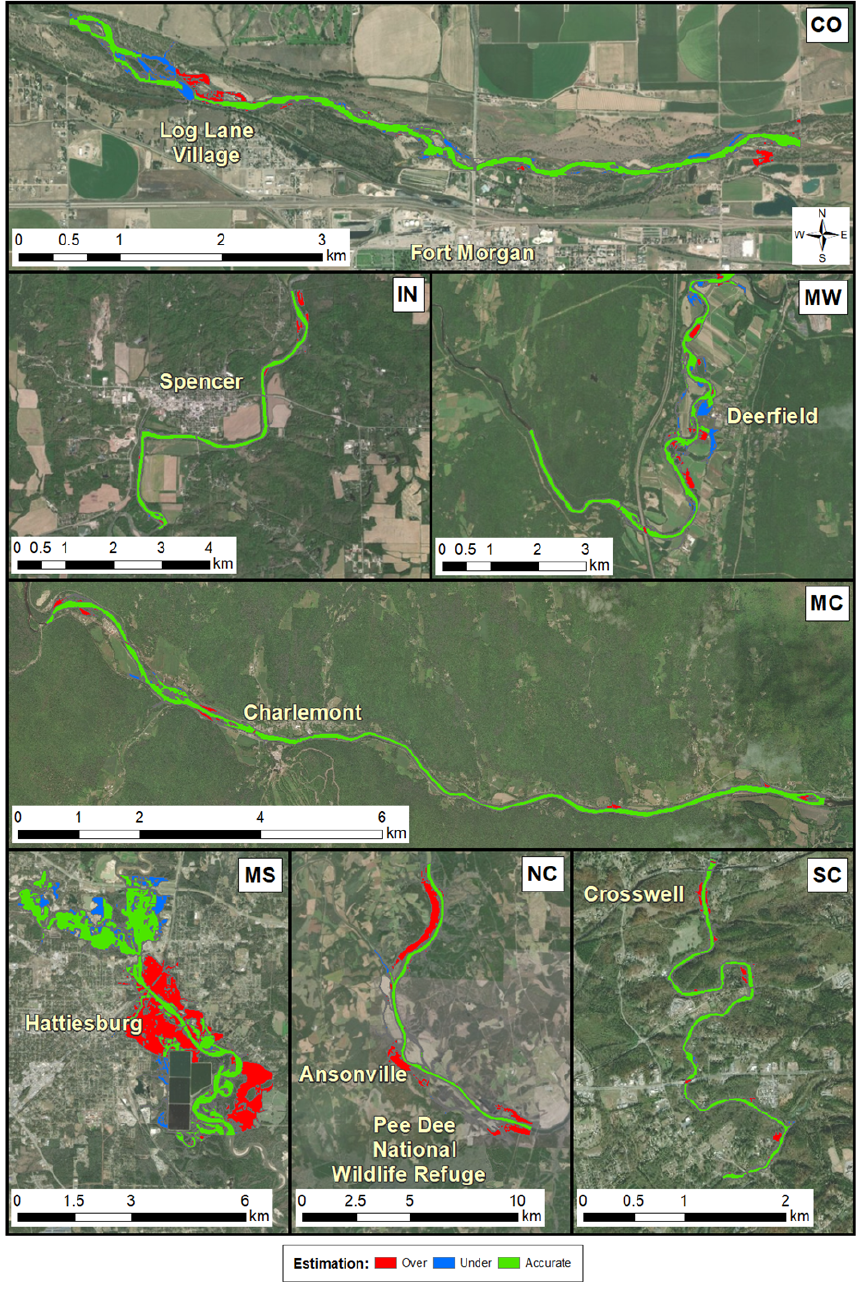
Figure 5. Flood map comparison between AutoRoute + ARPP simulations and USGS flood maps for low-flow events at the seven test sites. Areas shaded green (Accurate) indicate areas where AutoRoute + ARPP and the USGS flood maps agree. Areas shaded red (Over) indicate where only AutoRoute + ARPP simulates the area as flooded. Areas shaded blue (Under) indicate where only the USGS shows the area as flooded. Sources of the background imagery include ESRI, DigitalGlobe, Earthstar Geographics, CNES/Airbus DS, GeoEye, USDA FSA, USGS, Getmapping, Aerogrid, IGN, IGP, and the GIS user